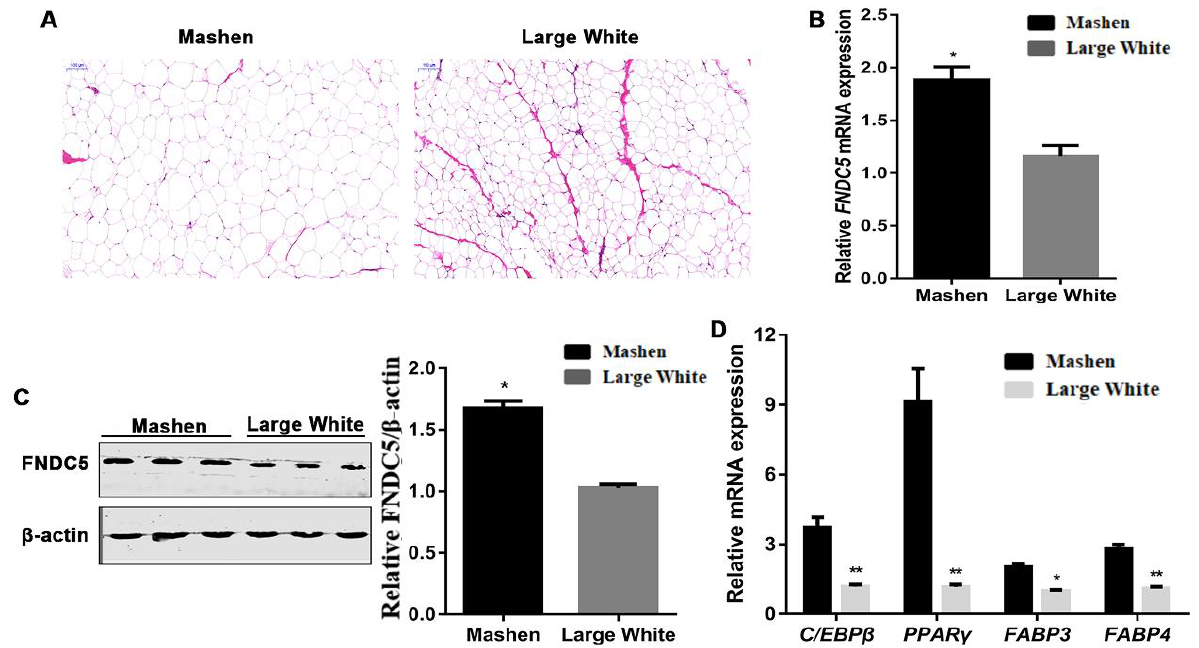
Figure 2. Difference in back fat between Mashen and Large White pigs. ( A ) HE staining results. ( B ) The expression of FNDC5 . ( C ) Western blotting result of FNDC5. ( D ) The expression of adipogenic marker genes. Scale bars: 100 µ m. Notes: “**” means extremely significant difference ( p < 0.01) and “*” means significant difference ( p < 0.05).